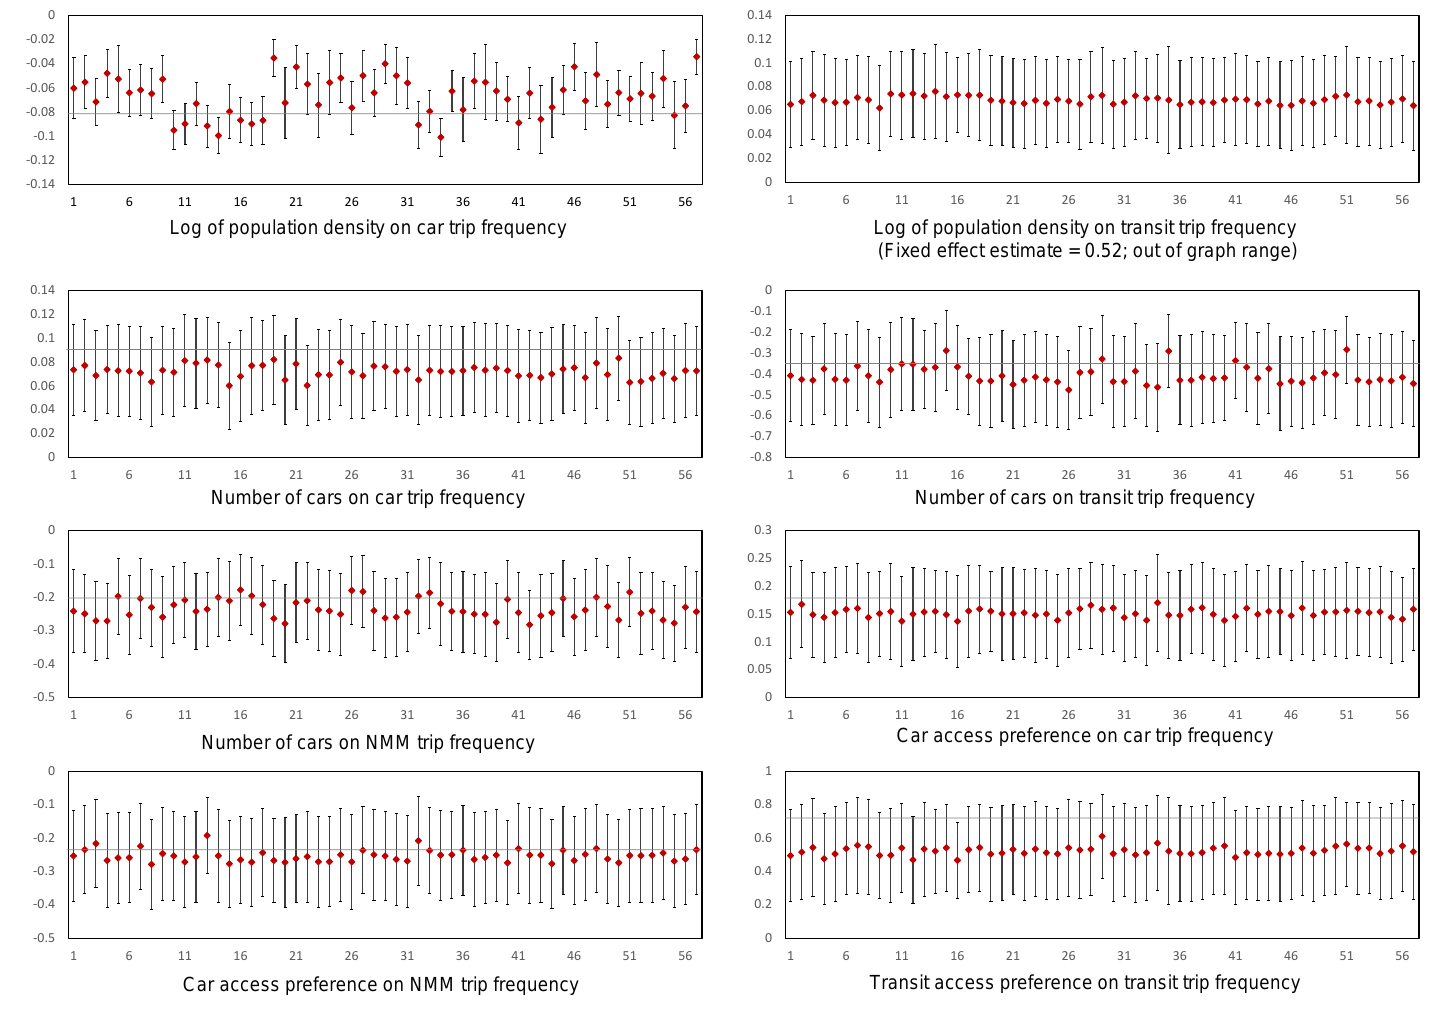
Figure 2. 95% Confidence intervals of estimated random parameters for full